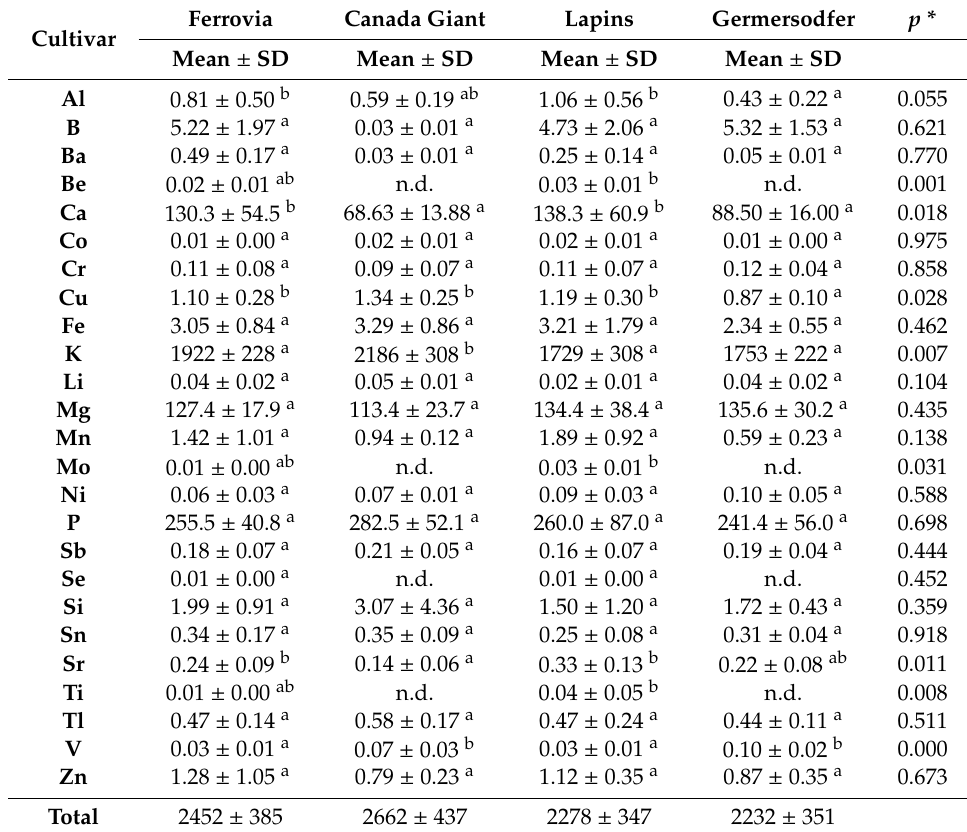
Table 3. Mean values and SD of minerals of cherry samples